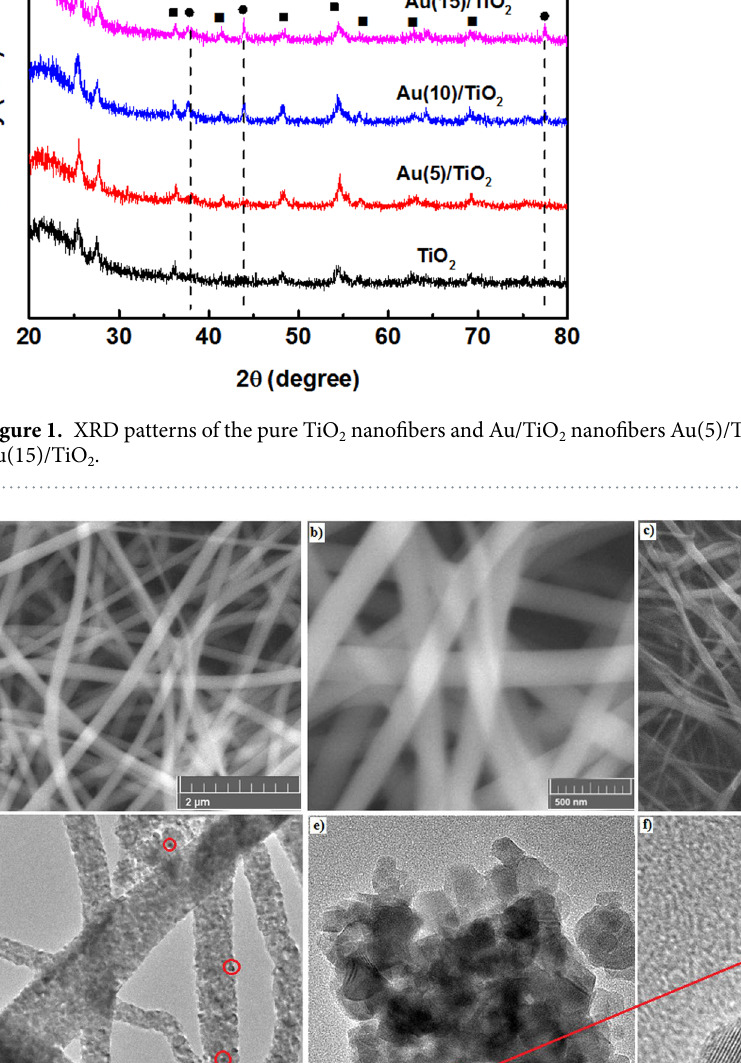
Figure 3 indicates the UV-Vis absorption spectra of the pure TiO 2 , Au(5)/TiO 2 , Au(10)/TiO 2 , Au(15)/TiO 2 nanofibers. It can be observed that the pure TiO 2 nanofiber has a sharp absorption edge at 420 nm, which is corresponding to TiO 2 band gap excitation. The Au/TiO 2 nanofibers were